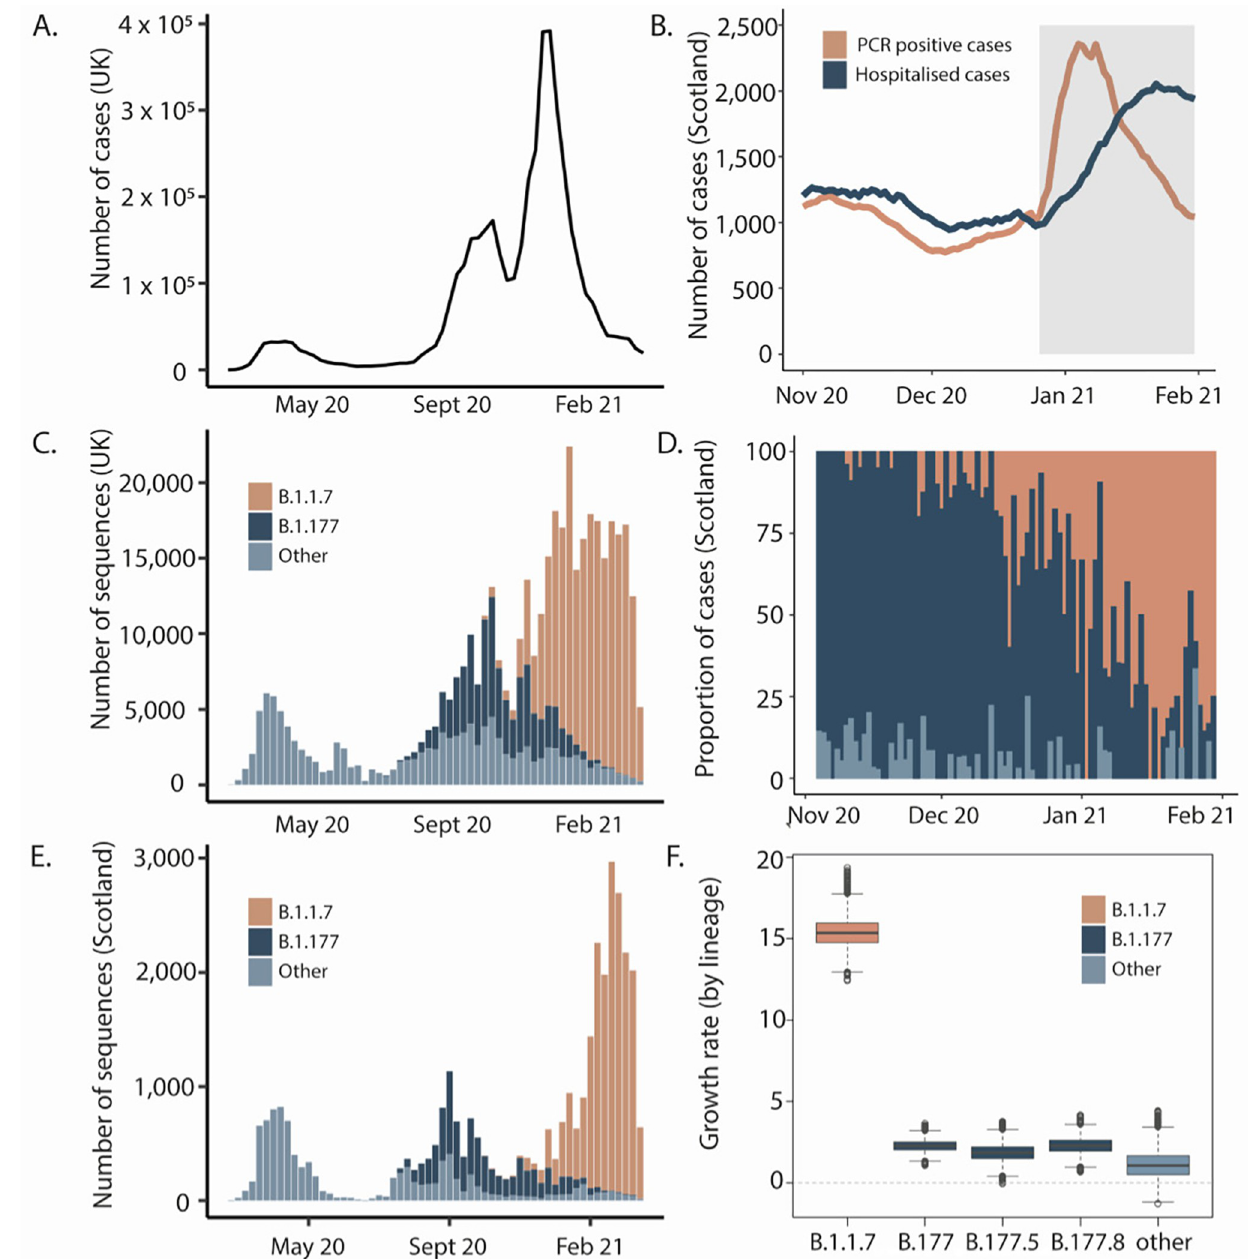
Fig 1. Introduction and growth of the Alpha variant (lineage B.1.1.7) in the UK, 2020/21. A) Waves of SARS-CoV-2 confirmed cases in the UK. B) Seven-day rolling average of daily PCR positive cases (orange) and total number of patients hospitalised (dark blue) with COVID-19 in Scotland during the study period. Grey shaded area represents the period of lockdown beginning 26/12/2020. C) Variants in the UK. D) Proportion of cases by lineage in the clinical severity cohort. E) Variants in Scotland showing three distinct waves in winter and early spring 2020, summer 2020 and autumn/winter, attributed to the shifts from B1 and other variants (light blue) to B.1.177 (dark blue) and then B.1.1.7/Alpha (orange). Waves one and two closely mirror the broader UK situation as they are linked to both continental European and introductions from England. Wave three has a single origin in Kent so Scotland lags England in numbers of cases. F) Estimates of growth rates of major lineages in Scotland from time-resolved phylogenies. Estimates were carried out on a subsample of the named lineages using sequences from Scotland only from November 2020-March 2021 using BEAST and an exponential growth effective population size